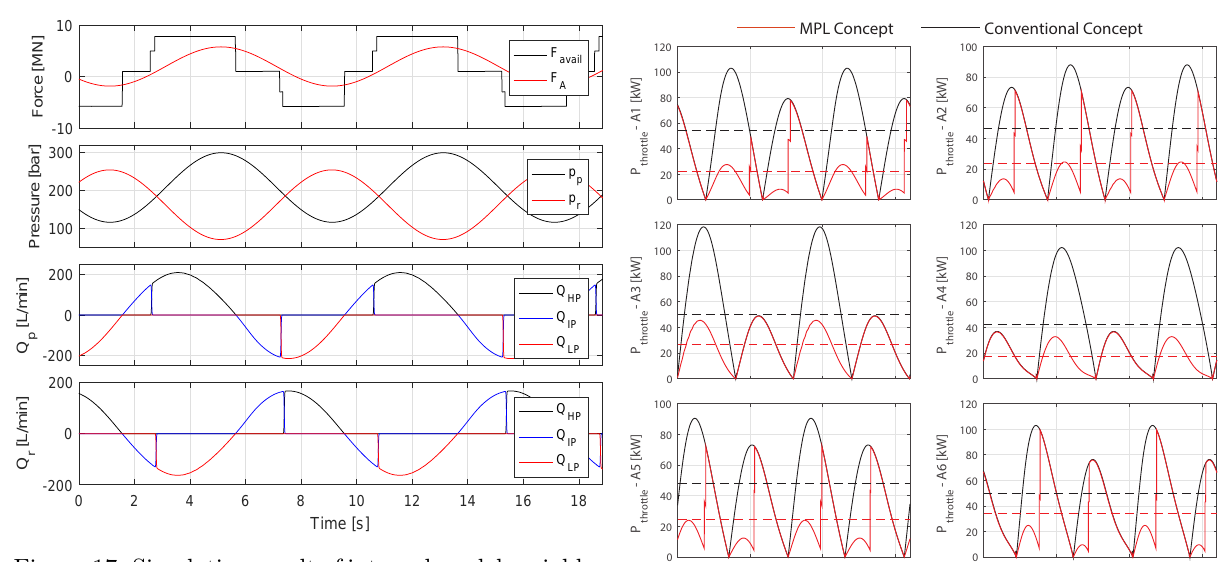
Figure 17: Simulation result of internal model variables of the MPL system.